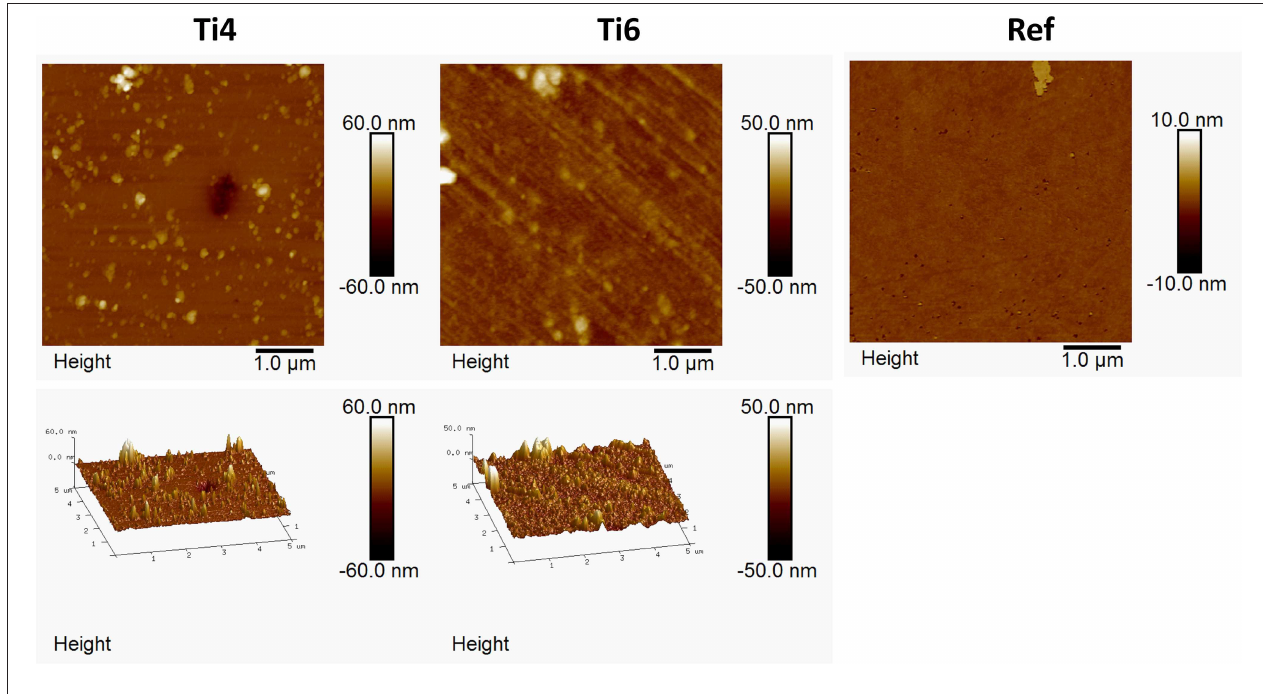
FIGURE 3 | 2D and 3D AFM images of selected TiO 2 -coated samples.